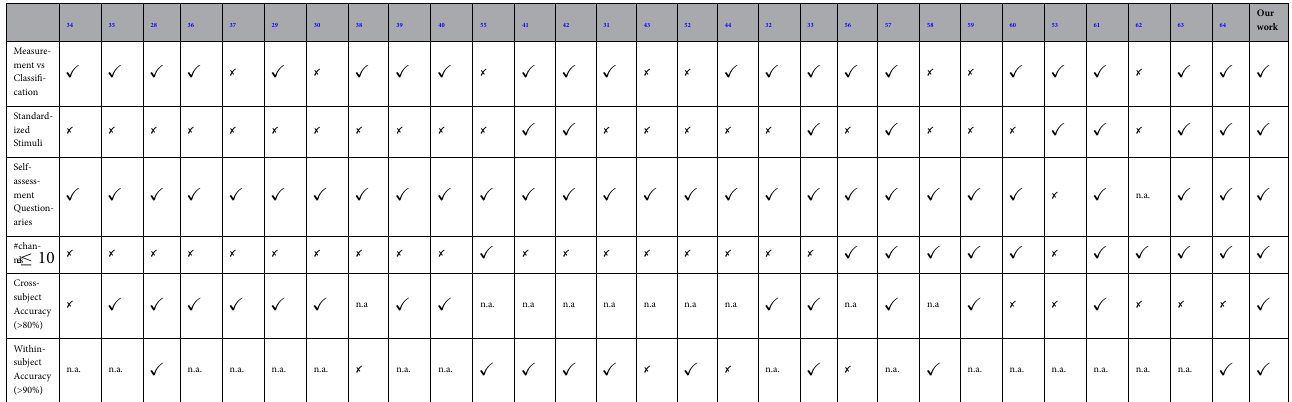
Table 8. Studies on emotion recognition classified according to metrological approach, number of channels and accuracy (n.a. = "not available", (cid:31) = "the property is verified". Only for the first line, (cid:31) = "Measurement"